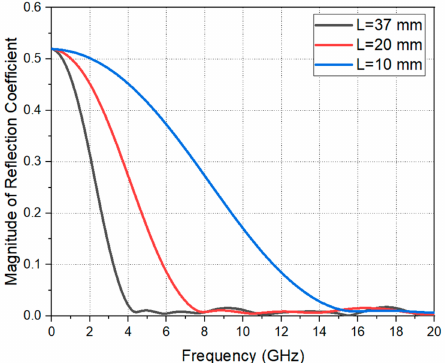
Figure 7. Simulated magnitude of the reflection coefficient of the MSL taper by increasing the physical length L . Here, Γ m = 0.02, Γ 0 =